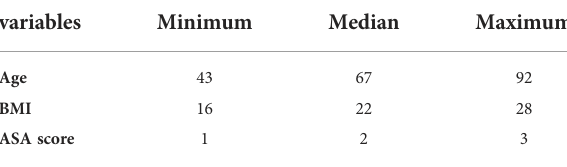
TABLE 1 Summary of continuous variables